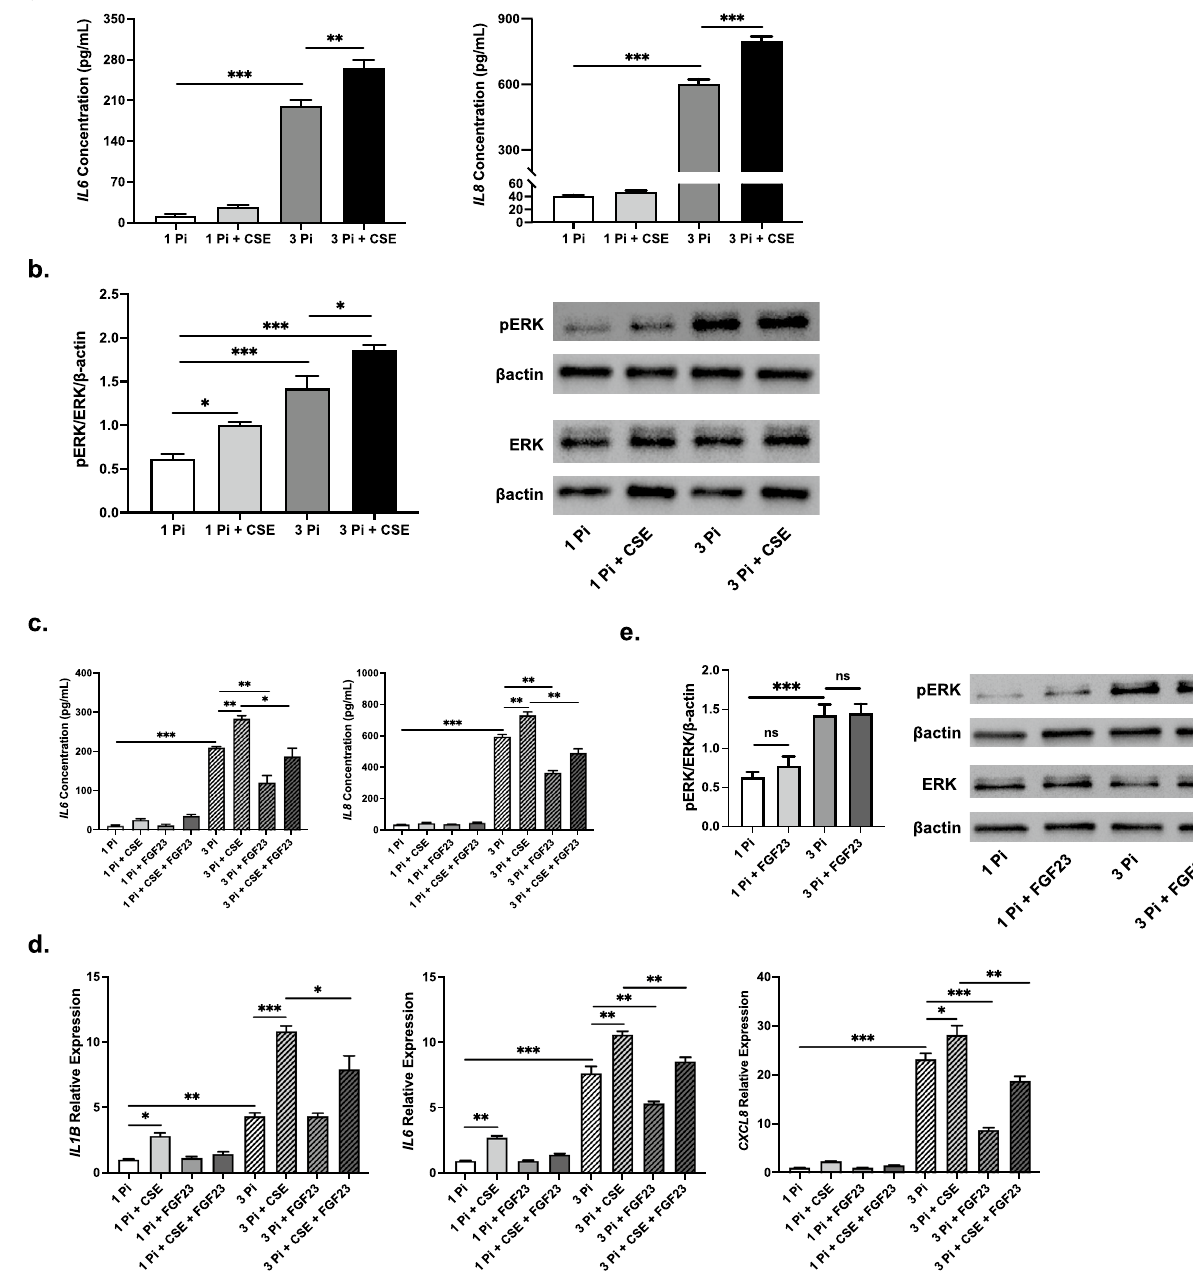
Figure 6. Cigarette smoke exacerbates phosphate-induced inflammatory cytokine expression and secretion, which is partially attenuated by FGF23. ( a ) IL6 and IL8 protein concentrations in conditioned media from BEAS-2B HBECs after 24 h sodium phosphate (Pi) stimulation with CSE. ( b ) Representative immunoblots and quantification of ERK phosphorylation in total protein extracts. βactin serves as loading control. ( c ) IL6 and IL8 protein levels in conditioned media after 24 h Pi stimulation with and without CSE and/or FGF23 cotreatments. ( d ) Relative mRNA transcript levels of IL1B , IL6 , and IL8 with Pi, CSE, and FGF23 cotreatments. ( e ) Representative immunoblots and quantification of ERK phosphorylation in total protein extracts from BEAS-2B HBECs after Pi stimulation with and without FGF23 cotreatment. βactin serves as loading control. All experiments were reproduced 3 times with triplicates. All values are mean ± SEM with *p ≤ 0.05, **p < 0.01, and ***p < 0.001. Original western blots presented are available in Supplemental Fig. S3. Statistical significance was analyzed via two-way ( a , b , e ) or three-way ( c , d ) ANOVA followed by Tukey’s multiple comparison post hoc